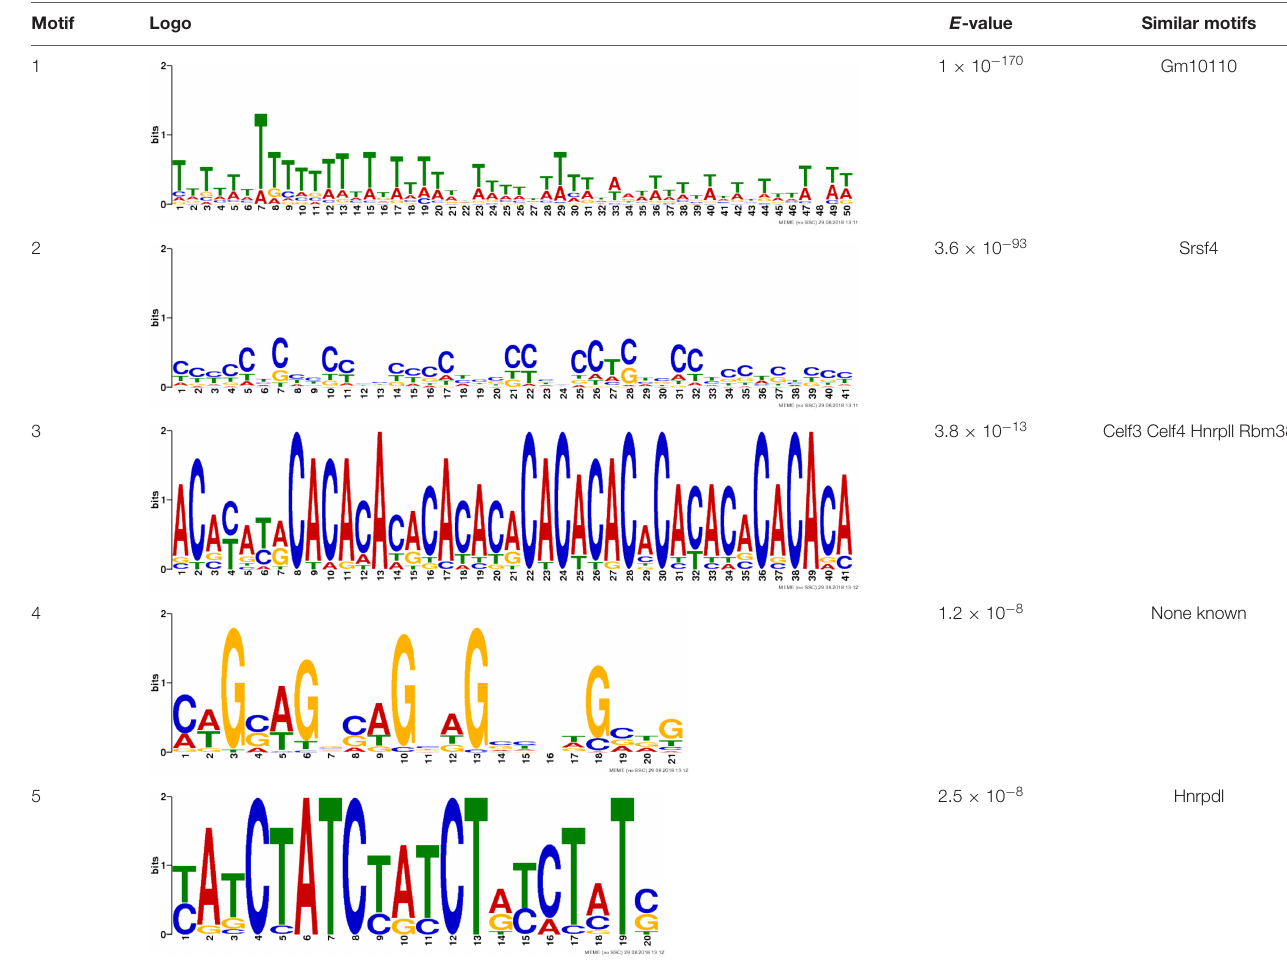
TABLE 1 | Sequence motif discovery in P2 ethanol sensitization-regulated exons. Motif